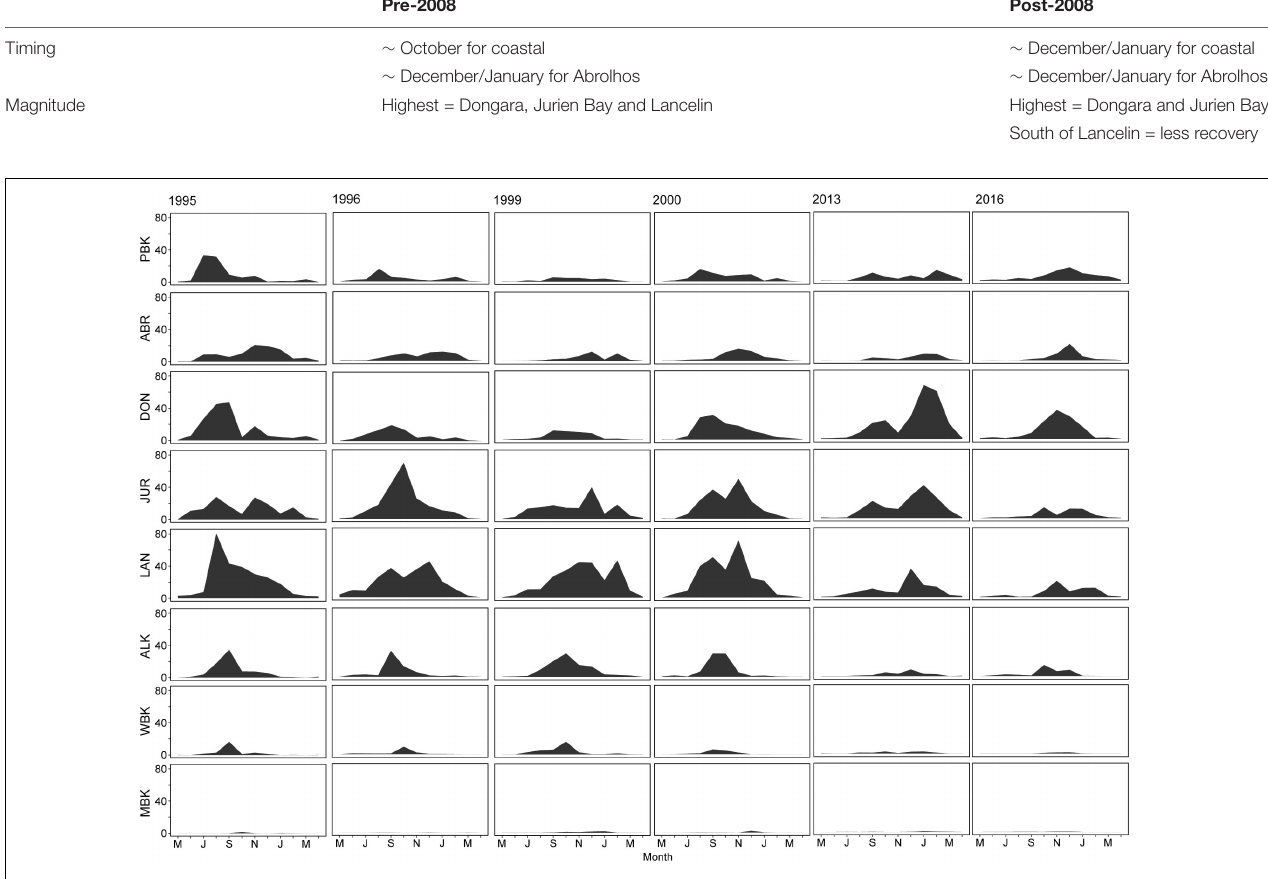
FIGURE 6 | Monthly puerulus numbers on collectors at each monitoring site over select seasons from north to south as the top to bottom of the